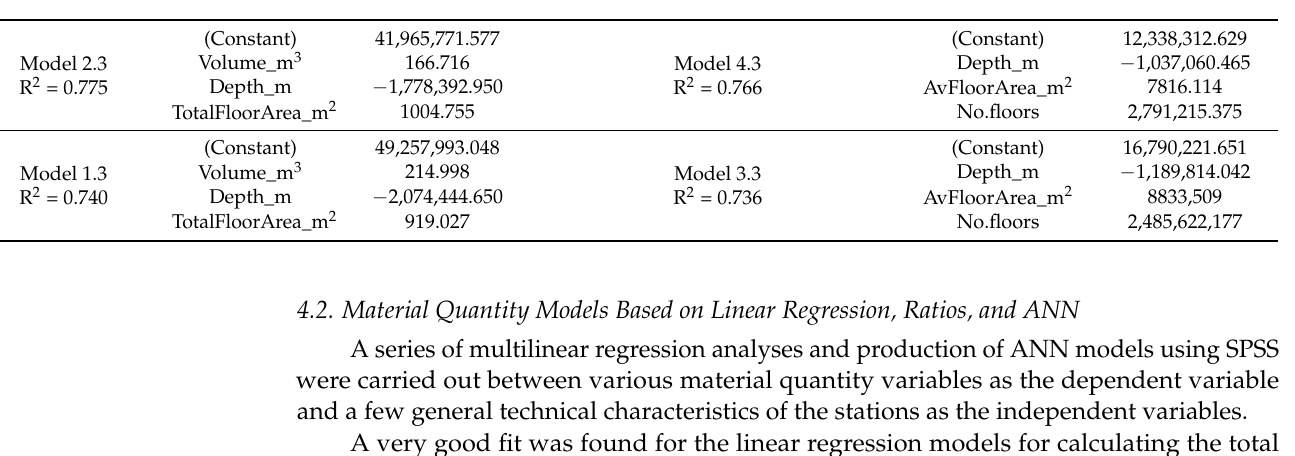
Table 6. Best-fitting regression